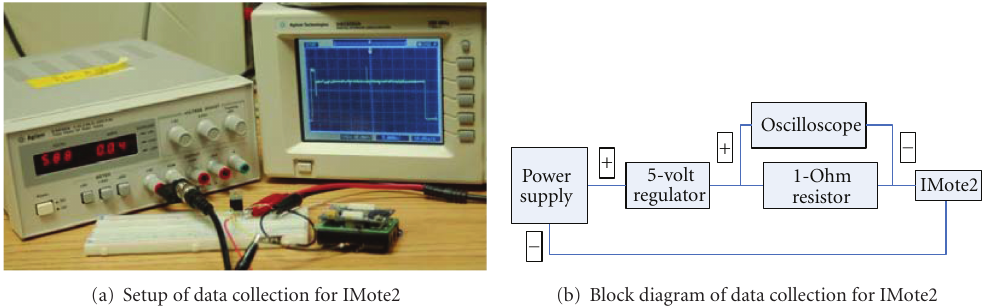
(b) Block diagram of data collection for IMote2 Figure 12: IMote2 power collection setup.